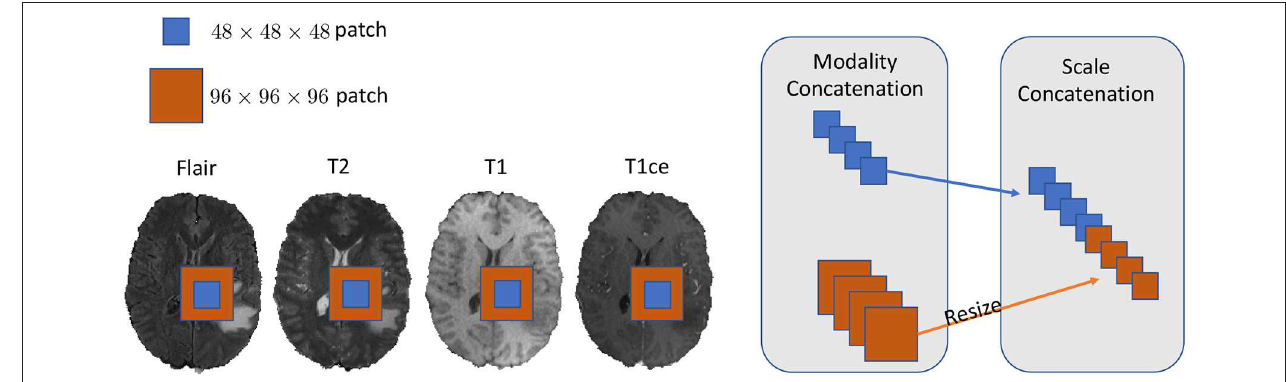
FIGURE 2 | In this figure, we show the example of how to reconstruct our training data in the 2D aspect for better comprehensive as it is easy to implement in 3D level as well. We concatenated the Flair, T2, T1, and T1ce models in the channel dimension and combined extra scale information to enhance the model training.